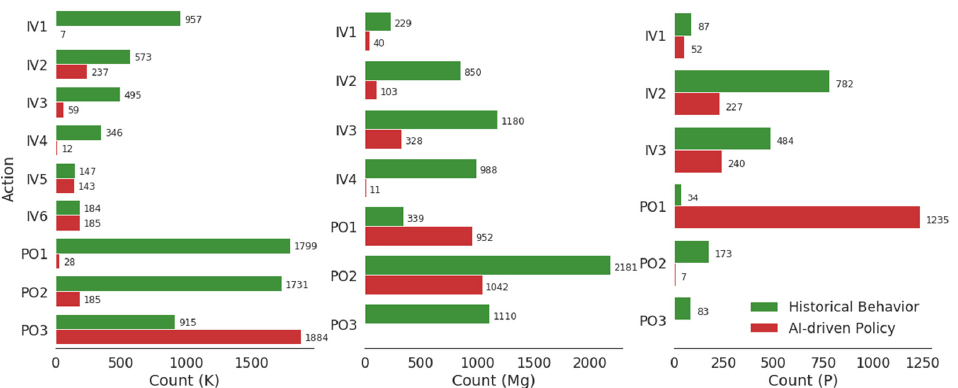
Figure 3. Distribution of repletion dosage levels chosen for three electrolytes in the historical data (UPHS) vs. dosages recommended by the learned RL policy.